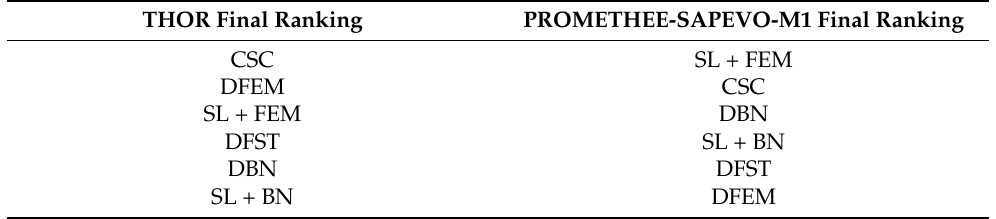
Table 6. Final ranking in both